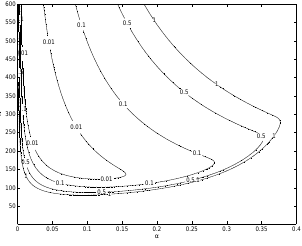
Figure 4. Contour plots of q T ( α,N,m ) N + q R, 1 ( α,N,m,r 0 ) N for m = 6 and r 0 = 0 . 1